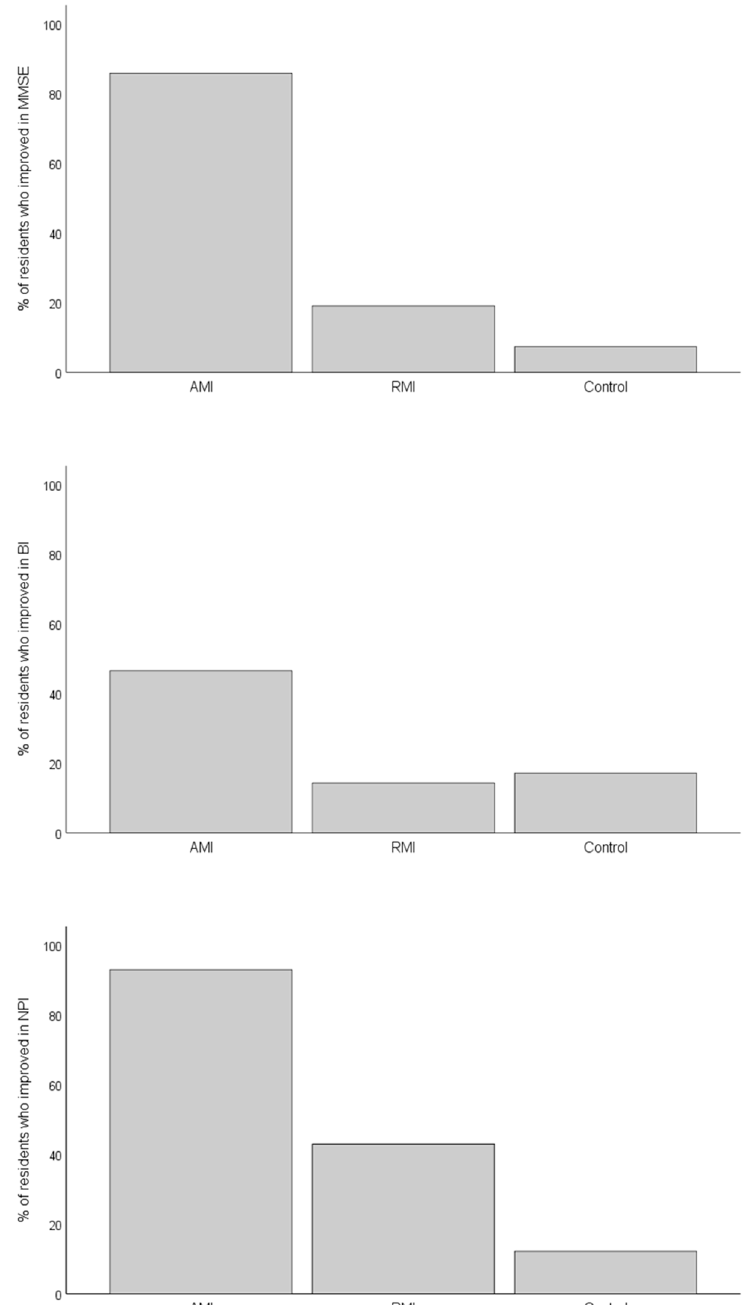
Figure 2. Graphical representation of the percentage of residents who improved in MMSE, NPI, and BI by group. AMI, active music intervention; BI, Barthel index; MMSE, Mini Examination of the Mental State; NPI, Neuropsychiatric Inventory; RMI, receptive music intervention. p < 0.001 in χ 2 test.